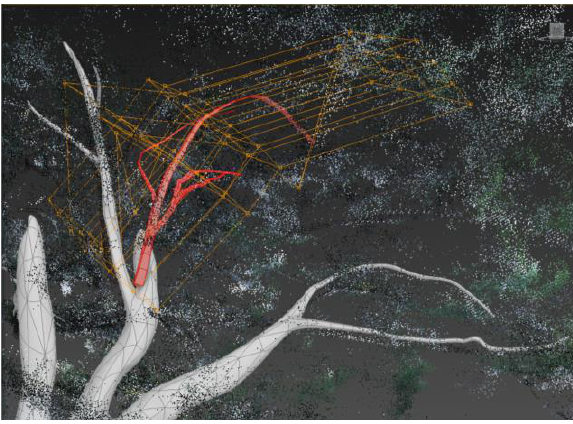
Figure 5. Revision of 3D trunk mode